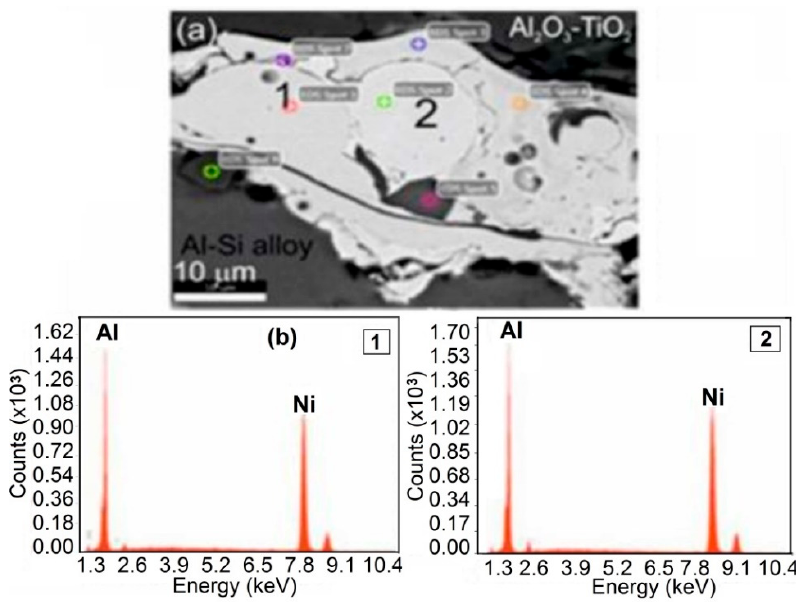
Figure 5. Scanning micrographs of HVOF sprayed Al 2 O 3 -15 wt.% TiO 2 coating with the NiAl interlayer on the Al-Si cast alloy: ( a ) SEM image of the NiAl interlayer with, ( b ) EDS spectra taken from the marked points: 1 and 2.